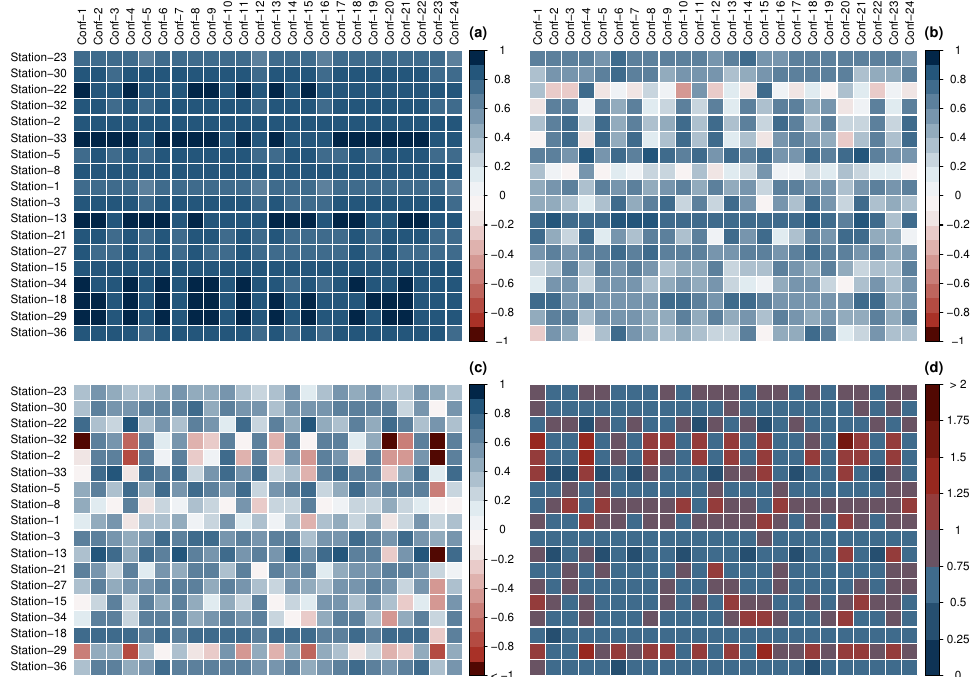
Figure A2. Matrix of statistics for minimum temperature: ( a ) correlation, ( b ) KGE, ( c ) NSE, ( d ) RSR.